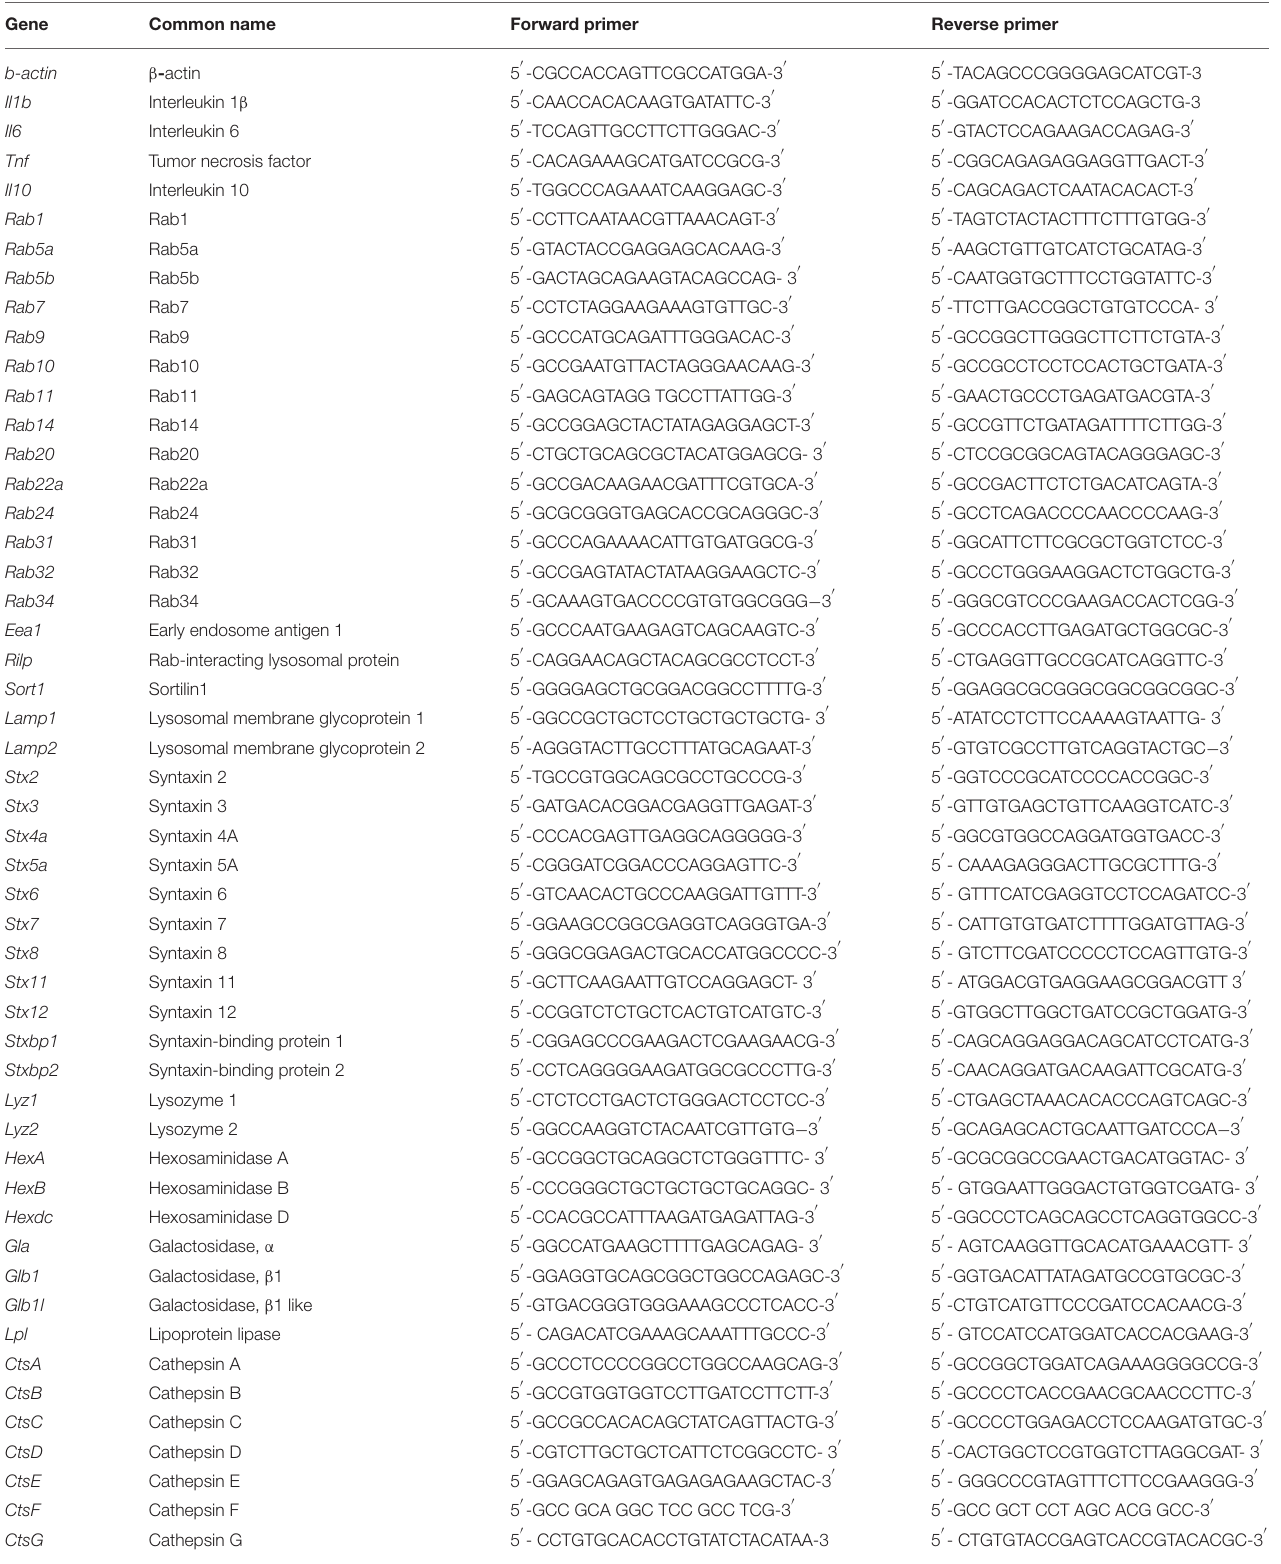
TABLE 1 | List of primer sequences used for